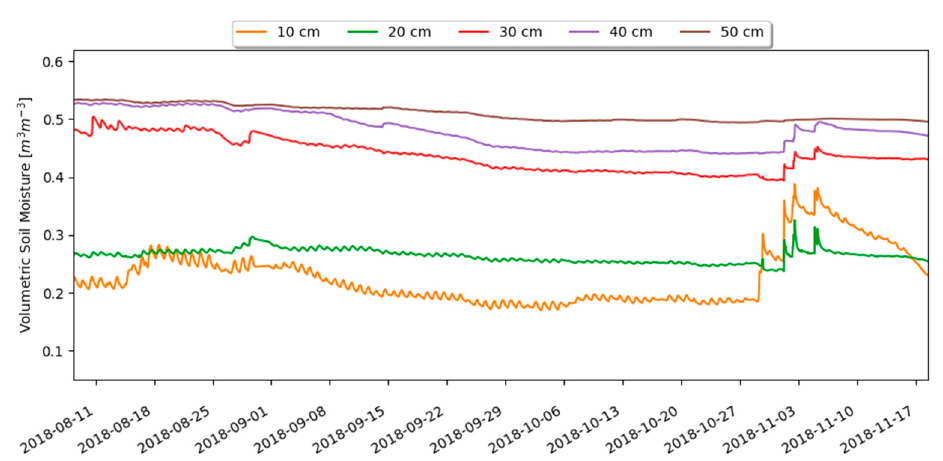
Figure 6. Volumetric soil moisture from Sentek sensor in Lagosanto for the field test period, from August 8, 2018 to November 11, 2018.